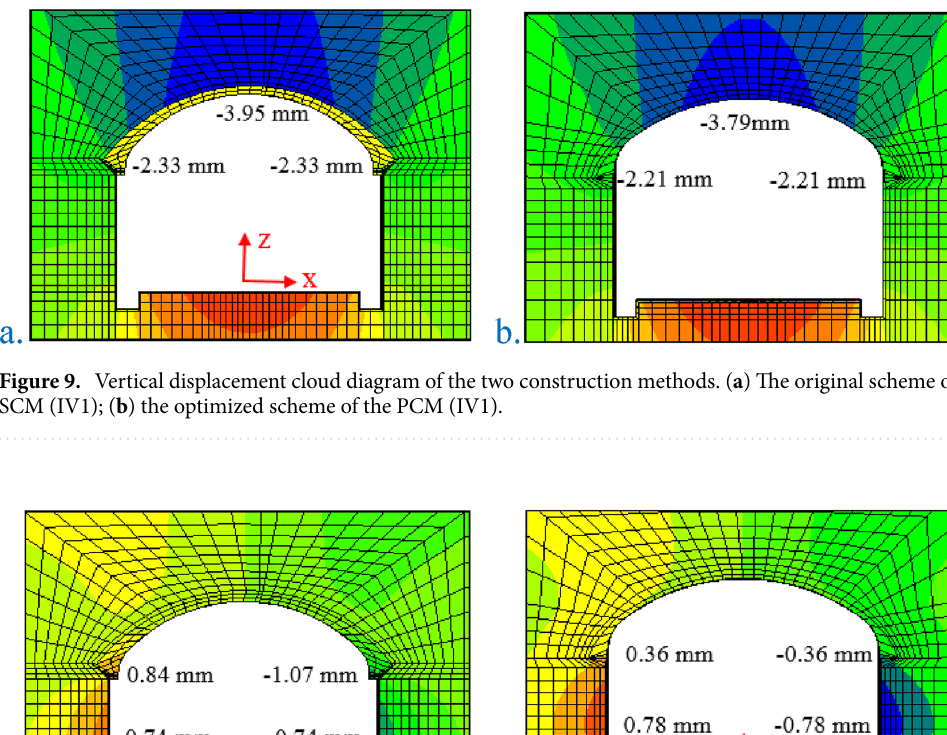
Vertical displacement. The vertical displacement cloud diagram of the two construction methods is shown in Fig. 9. When all excavation of the original scheme of the SCM was completed, the vertical displacement of the arch crown was − 3.95 mm, the vertical displacement of the left arch foot was − 2.33 mm, and the vertical dis- placement of the right arch foot was − 2.33 mm. When all excavation of the arch cover method was completed, the vertical displacement of the arch crown was − 3.79 mm, the vertical displacement of the left arch foot was − 2.21 mm, and the vertical displacement of the right arch foot was − 2.21 mm. The settlement of the arch crown caused by the arch excavation of the two construction methods accounted for 96.5% and 93.4% of the total set- tlement. With the same parameters, the vertical displacement of the arch crown of PCM was − 3.79 mm, and the vertical displacement of the arch crown of the two lining arch cover methods was − 3.95 mm. The arch settle- ment of PCM was 4.8% lower than that of the SCM. Horizontal displacement. The horizontal displacement cloud diagram of the two construction methods is shown in Fig. 10. When all excavation of the original scheme of the SCM was completed, the horizontal dis- placement of the left arch foot was 0.84 mm, the horizontal displacement of the right arch foot was 1.07 mm, and the displacement of the left and right sidewalls was 0.79 mm, both moving to the inner side of the arch. When all excavation of the arch cover method was completed, the horizontal displacement of the left and right arch feet was 0.36 mm, and the displacement of the left and right sidewalls was 0.78 mm, all moving to the inside of the arch.